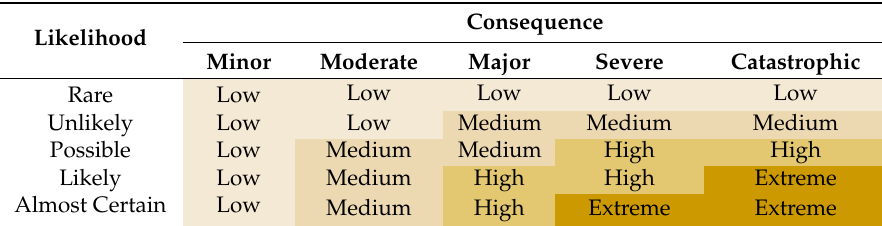
Table 5. Level of Impact (Impact Risk) for Describing Negative